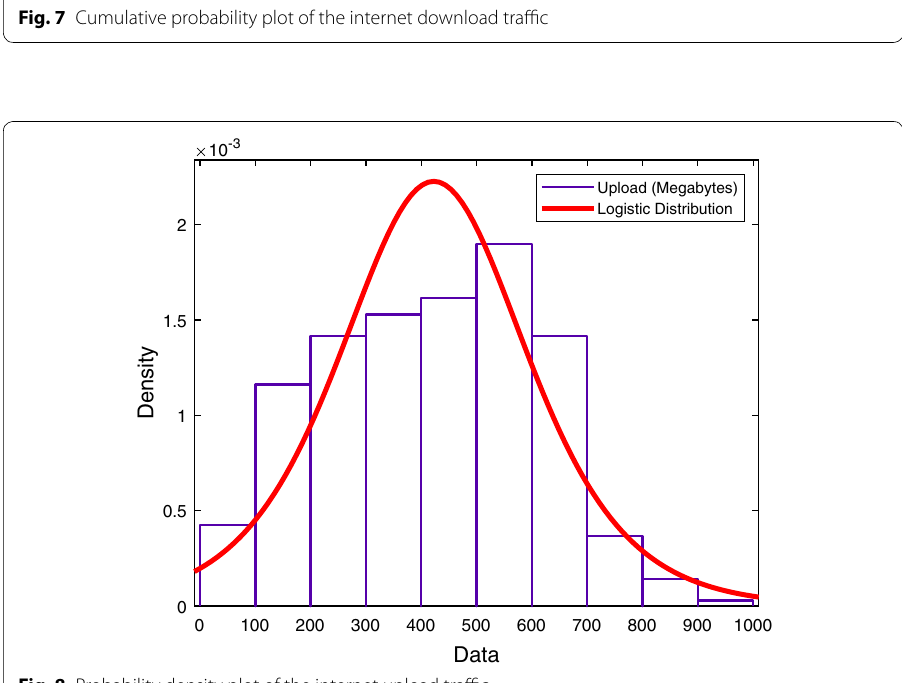
Fig. 8 Probability density plot of the internet upload